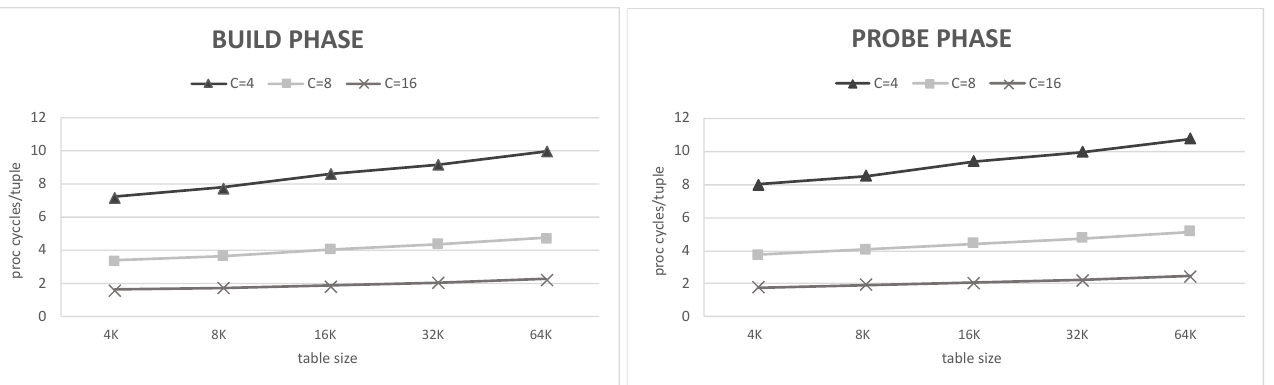
Figure 6. The average number of cycles per tuple in build phase and probe